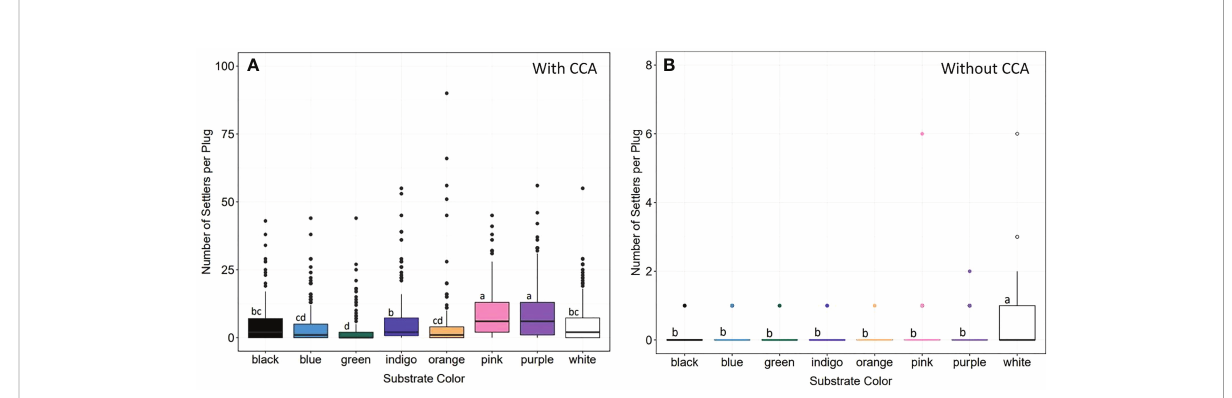
FIGURE 11 Larval settlement preferences and spectral cues. (A) Settlement density on eight different colored substrates with CCA. Larvae settled on all colors, but in signi fi cantly higher densities on pink and purple substrates (statistics in text). Green was the least popular, followed by blue and orange. (B) Settlement density on differently colored substrates without CCA. There were signi fi cant differences across groups (statistics in text), but larvae preferred white substrates. Letters denote signi fi cant differences between groups (Dunn test with Bonferroni correction